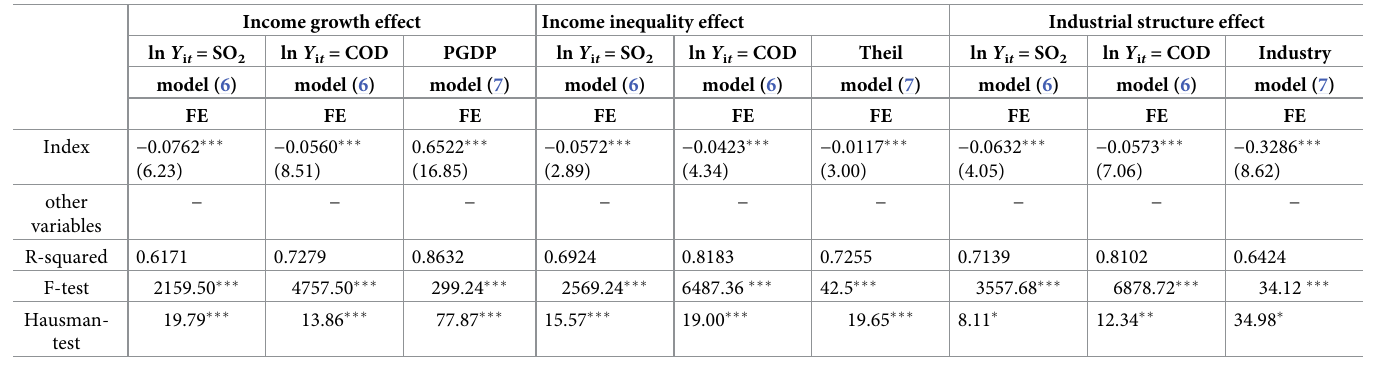
Table 4. Intermediate effect regression